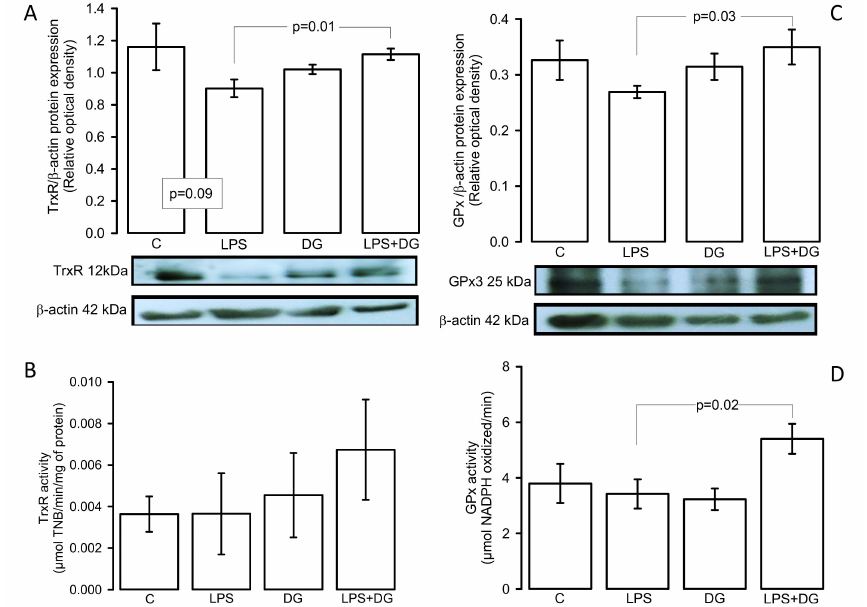
Figure 3. Enzymatic activities and expressions of the ( A ) TxrR expression, ( B ) TrxR activity, ( C ) GPx expression, and ( D ) GPx activity. Values are expressed as mean ± SE (n = 6). Abbreviations: C = control, DG = deodorized garlic, LPS = lipopolysaccharide, TrxR = thioredoxin reductase, GPx = glutathione reductase.